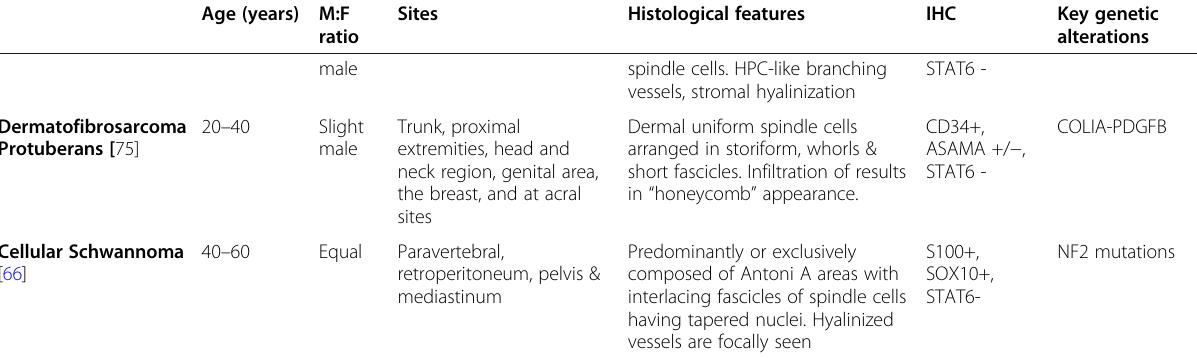
Table 1 Differential Diagnosis of Solitary Fibrous Tumor